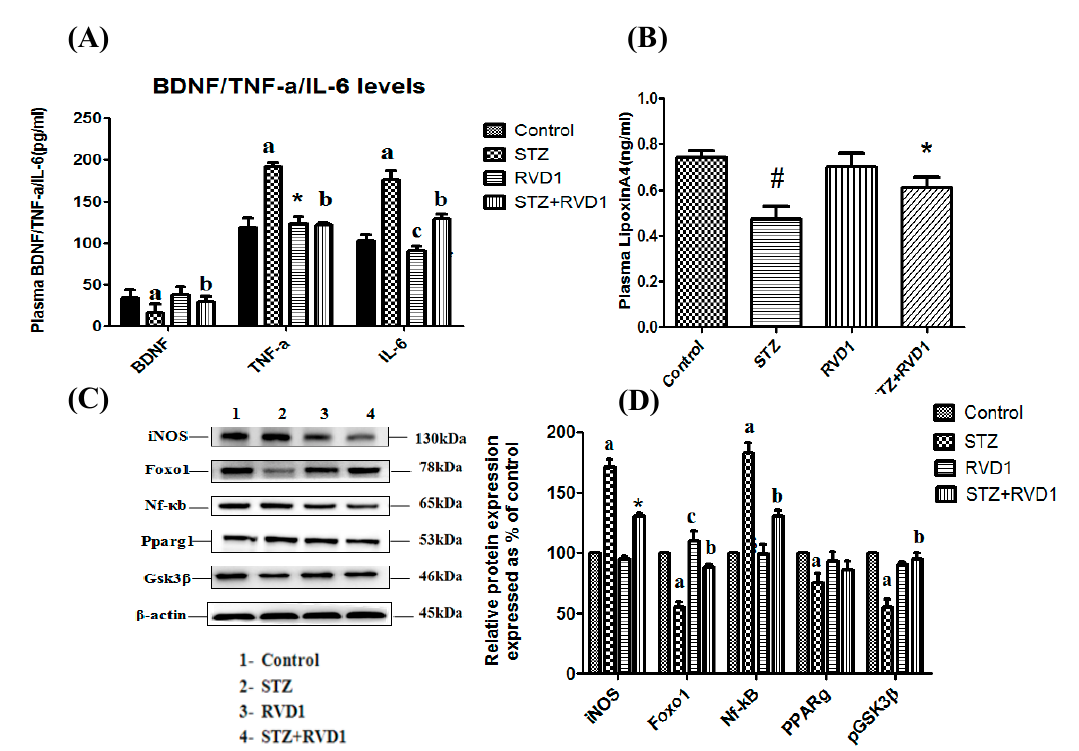
Figure 3. Effect of RVD1 treatment on plasma levels of BDNF/TNF- α /IL-6/LXA4 and protein expression in pancreatic tissue samples. ( A ) Plasma BDNF/TNF- α /IL-6 levels. Plasma BDNF level in STZ + RVD1 vs. STZ (T1DM)-treated groups estimated at the end of the study (day 30). b p ≤ 0.01 compared to STZ (T1DM) and a p ≤ 0.01 compared to untreated control; TNF- α studies: a p ≤ 0.001, * p ≤ 0.01 compared to control and compared to STZ control; and b p ≤ 0.05 compared to STZ (T1DM); IL-6 studies: a p ≤ 0.01 and c p ≤ 0.05 compared to untreated control and STZ control values. b p ≤ 0.01 compared to STZ (T1DM) group All values are expressed as mean ± SEM. ( B ) Measurement of LXA4 levels in the plasma of various groups measured at the end of the study (day 30). # p ≤ 0.001 compared to untreated control. * p ≤ 0.01 compared to STZ (T1DM) control (positive control group). ( C , D ) Protein expression studies in pancreatic tissue of the rats of various groups. Total protein extracted from the pancreatic tissue samples were collected at the end of the study (day 30) and used for Western blots for Nf- κ b, Foxo1, PPAR- γ , p -GSK3 β , iNOS, and beta actin. Equality of loading of the samples was confirmed by beta actin protein expression. All values are expressed as mean ± SEM. a p ≤ 0.01 and c p ≤ 0.05 compared to control values. b p ≤ 0.01 compared to STZ (T1DM). Table 1. Concentrations of various anti-oxidants, lipid peroxides, and nitric oxide in pancreatic tissue in vivo: Superoxide dismutase (SOD) is expressed as U SOD/mg of protein; Glutathione-S-transferase (GST) is expressed as µ M conjugate formed/minute/gm of protein; Catalase (CAT) is expressed as µ M of H 2 O 2 consumed/minute/mg of protein; Glutathione peroxidase (GPX) is expressed as µ g of glutathione consumed/minute/gm of protein. Nitric oxide formed is expressed as µ moles of nitrite formed. Lipid peroxides formed are expressed as µ moles of TMOP formed; * p ≤ 0.05, § p ≤ 0.01 vs. untreated control ** p ≤ 0.05 compared to STZ group. All values are expressed as mean ± SEM. Summary of the Analysis of Various Anti-Oxidant/Lipid Peroxides and Nitric Oxide Levels in Pancreas of Resolvin-D1/Stz-Treated Diabetic Rats SOD CAT (mM Tissue Group (Units/mg H 2 O 2 /min/mg protein) protein Pancreas